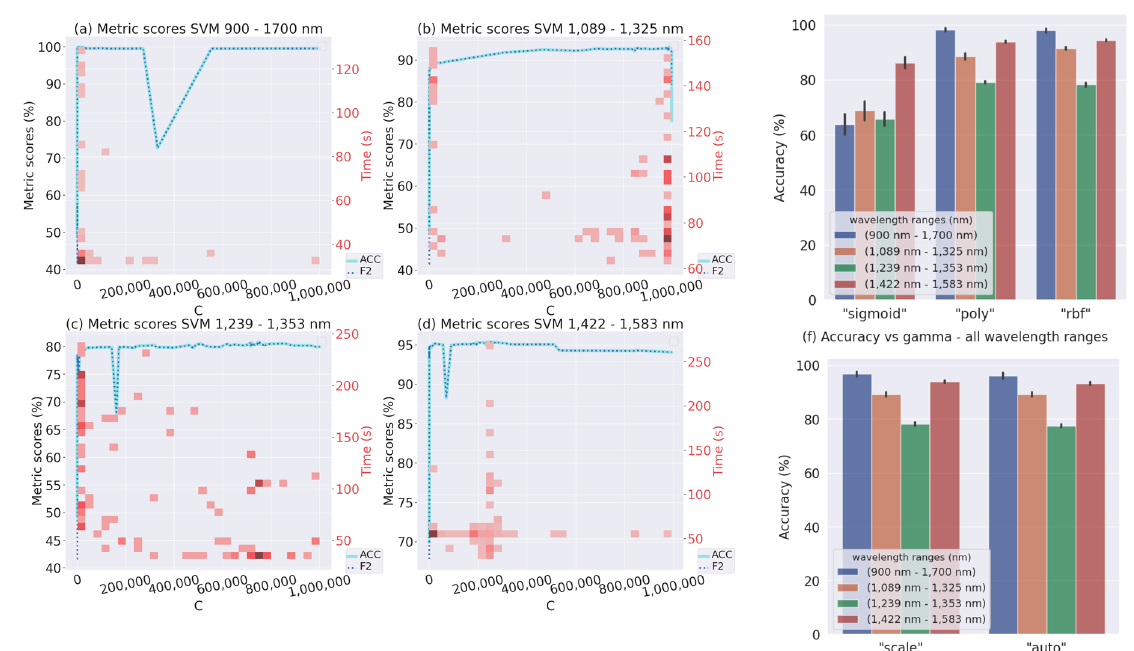
Figure 5. ( a – d ) show the Accuracy, F2 ‐ score, and time vs. the C hyperparameter. ( e , f ) show the accuracy vs. the kernel and gamma hyperparameters.